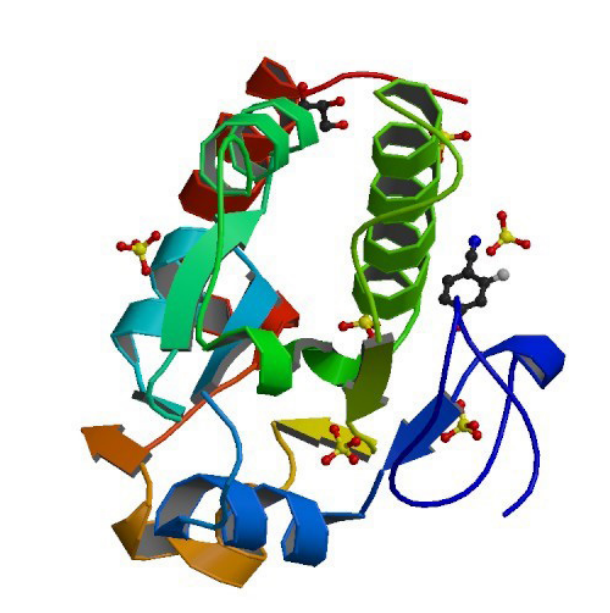
FIGURE 5 - 4WH7 Protein (3D structure). Structure of the CDC25B Phosphatase Catalytic Domain with Bound